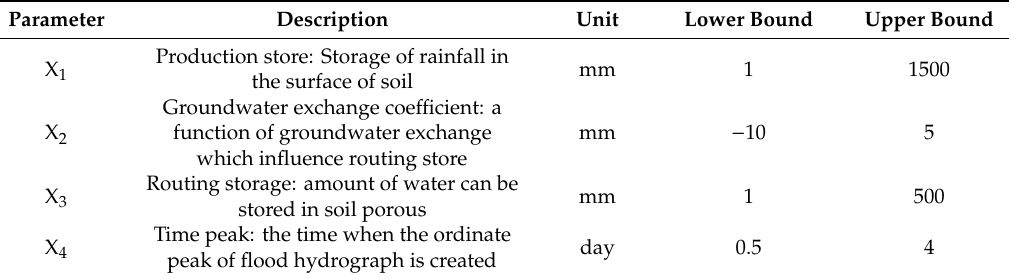
Figure 4. Diagram of GR4J model. Table 1. Description and ranges of parameters in GR4J model.